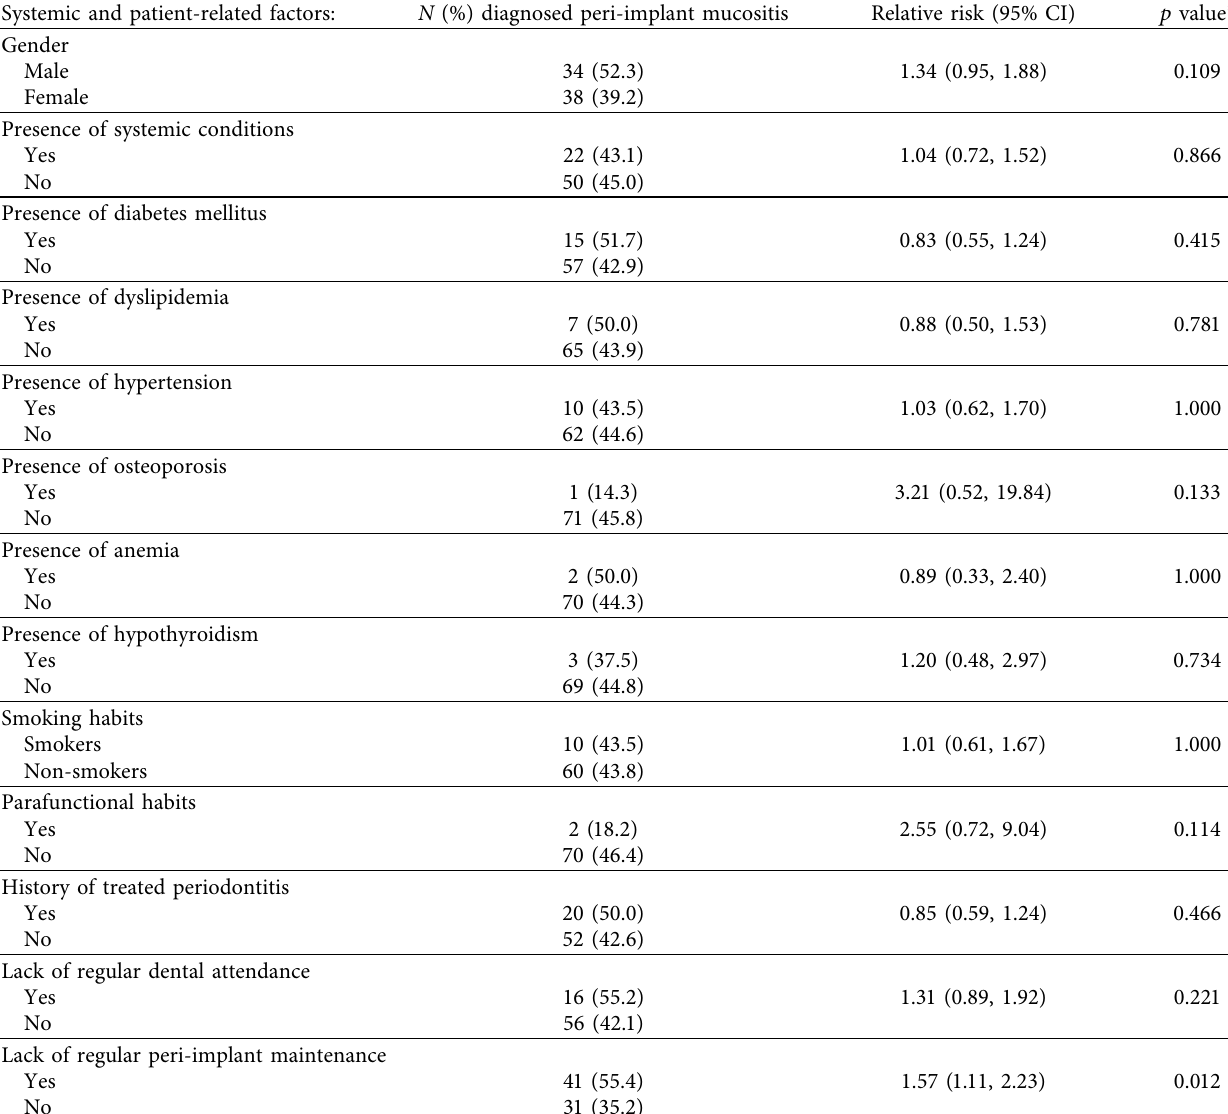
Table 1: Characteristics of patients diagnosed with peri-implant mucositis ( n �